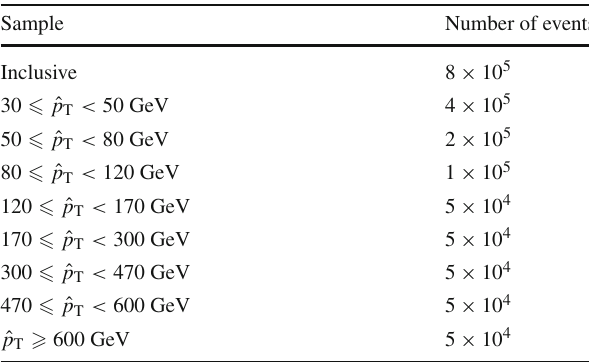
Table 5 Number of events in the inclusive and exclusive samples used to estimate trigger rates at the HL-LHC Sample Number of events